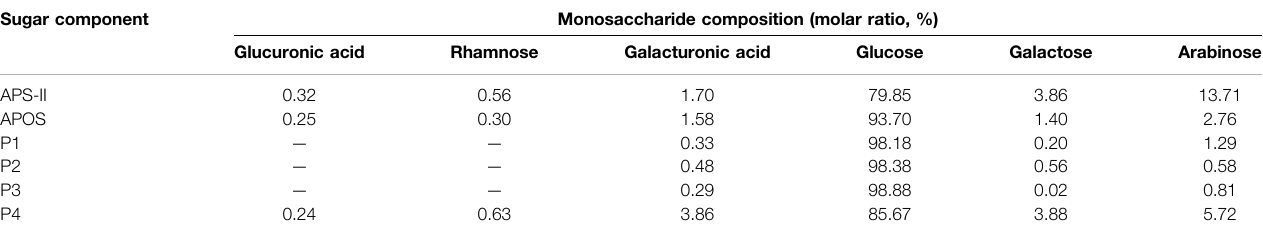
TABLE 1 | Results of monosaccharide composition analysis of different saccharide